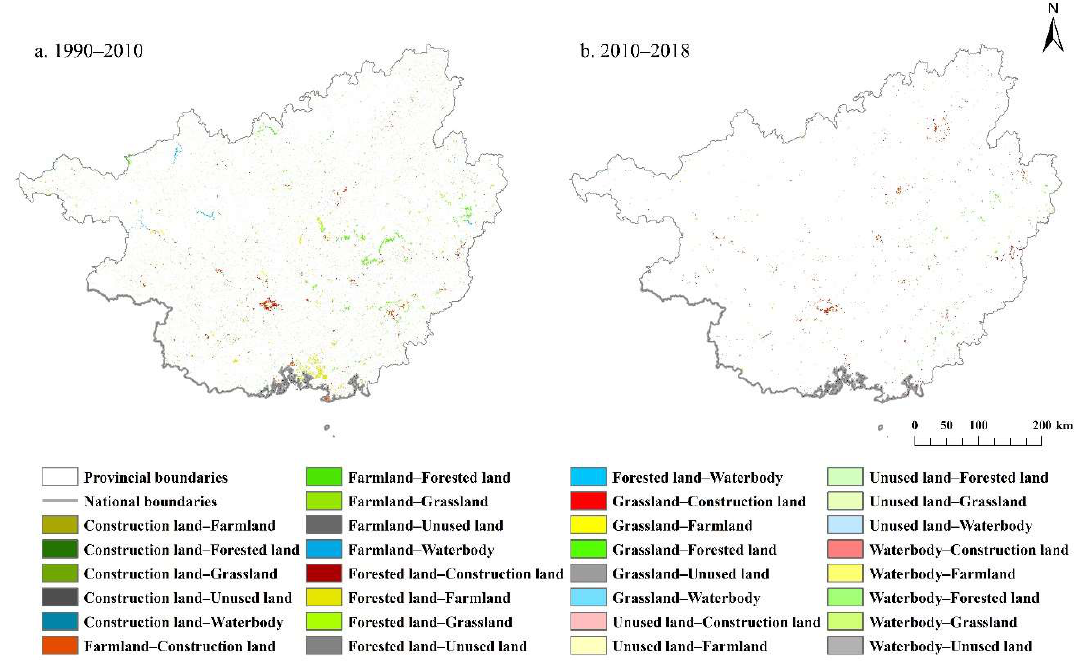
Figure 3. The spatial distribution of land use transitions in Guangxi during